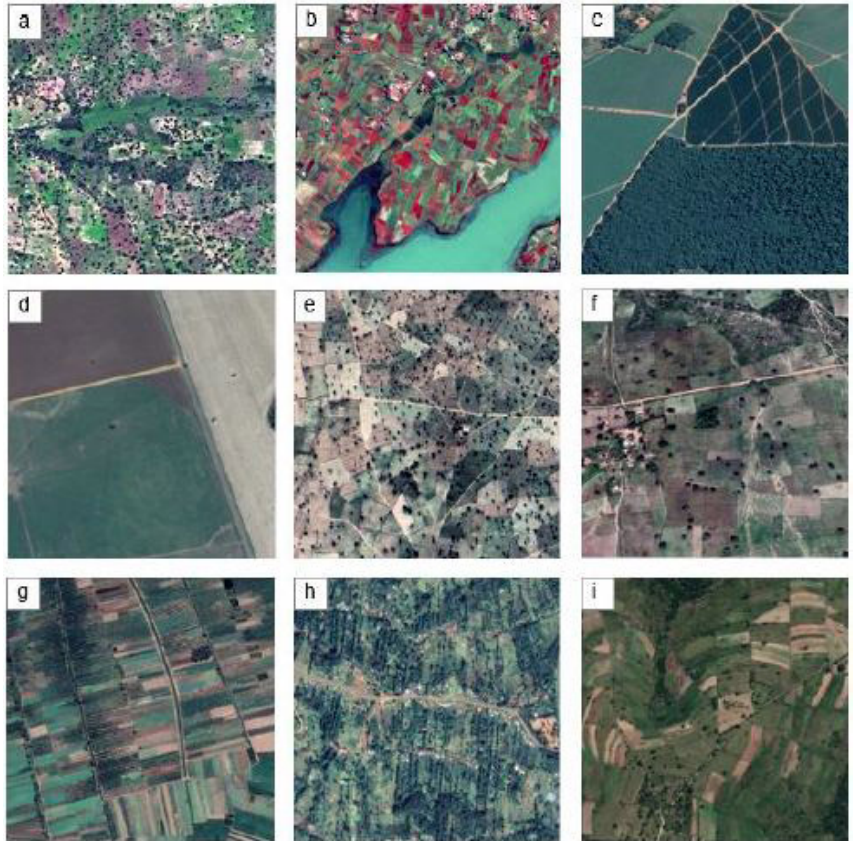
Figure 2. A 1km 2 sample of land showing the landscape variety across the sampled sites due to the farming system in place: (a) rainfed cereals in Burkina Faso; (b) rice systems in Madagascar; (c) agropastoral systems in Tocantins, Brazil; (d) mixed agriculture in São Paulo, Brazil; (e) rainfed groundnut and millet agropastoral systems in Niakhar and (f) in Nioro, Senegal; (g) irrigated rice systems and orchards in Cambodia; (h) agroforestry in Kenya; (i) mixed agriculture in South Africa. Images © Google Earth 2020.